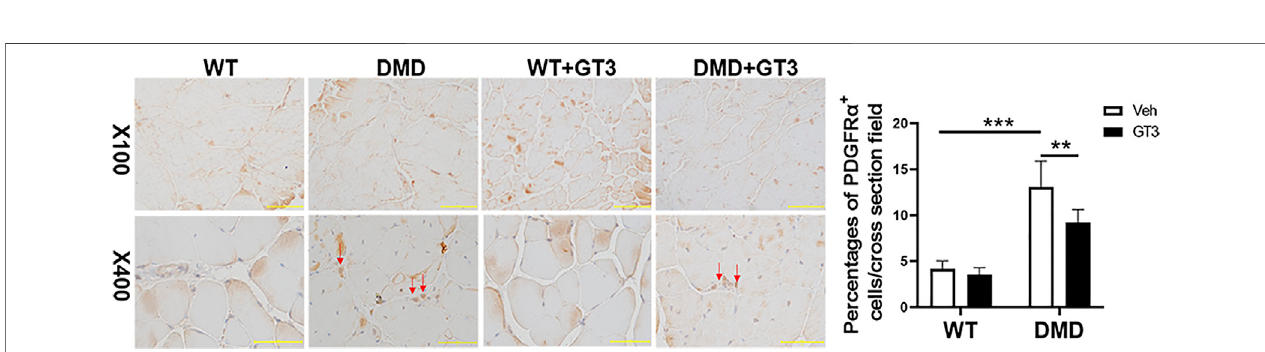
FIGURE 10 | Effect of GT3 treatment on fi brosis of the tibial anterior in DMD mice. DMD mice had more fi bro-adipogenic progenitors in the tibialis anterior which comparedwithWTmice.ThepercentagesofcellsweredecreasedafterGT3treatmentinDMDmice.Datawerepresentedatmeans±SEM( n =6)withtwo-wayANOVA analysis. ** p < 0.01, *** p <